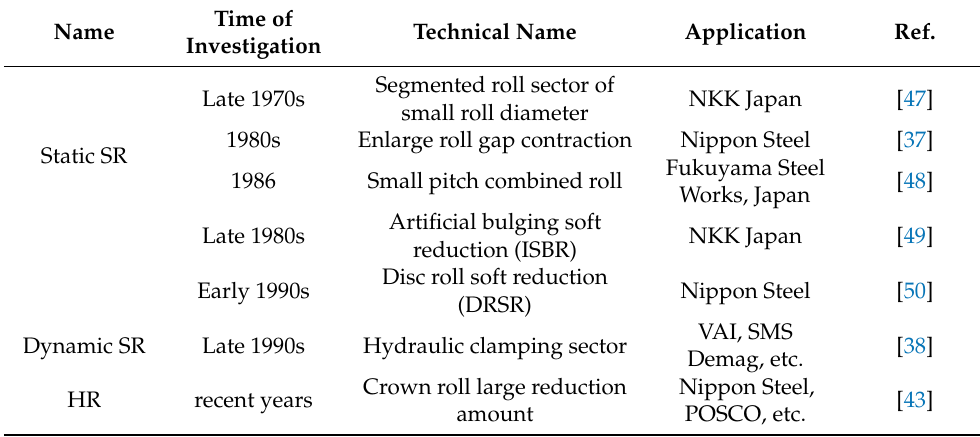
Table 3. Development history of reduction